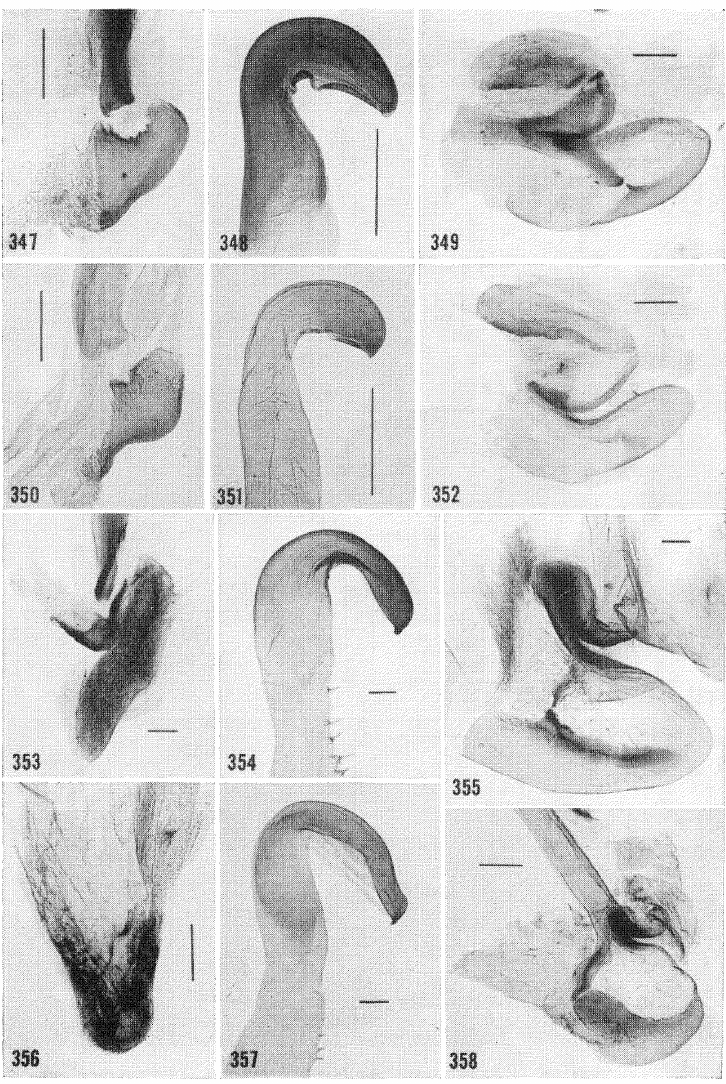
Figs. 347-358. Cockroach male genitalia. 347-352. Zludreia carinulata (Saussure). 347-349. (176 USNM). La Palma, Costa Riea. (det. Rehn). 350-352. Volean Barba, Costa Riea. (det. Fisk). 353-355. (81 USNM). Epilampra yersiniana. Silo Paulo Rio Cubatio, Brazil (det. Prineis). 356- 358. (181 ANSP). Epilampra shelfordi. Type 5345. El Cor:edo, Cauea, Colombia. (scale 0.2